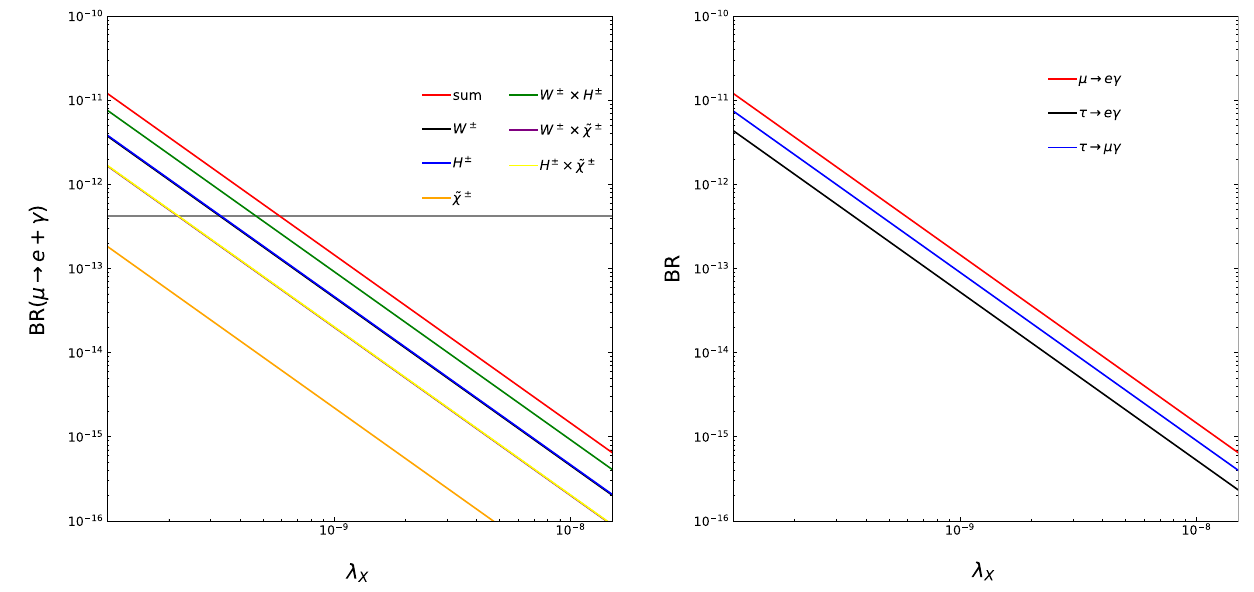
Fig. 7 Left: Branching ratio and its individual contributions for the decay μ → e γ as a function of λ X . The interference contributions W ± × ˜ χ ± between the chargino and the W ± form factors (violet), and H ± × ˜ χ ± between the chargino and charged Higgs form factors (yel- low) are negative. In order to present them in one plot we have changed